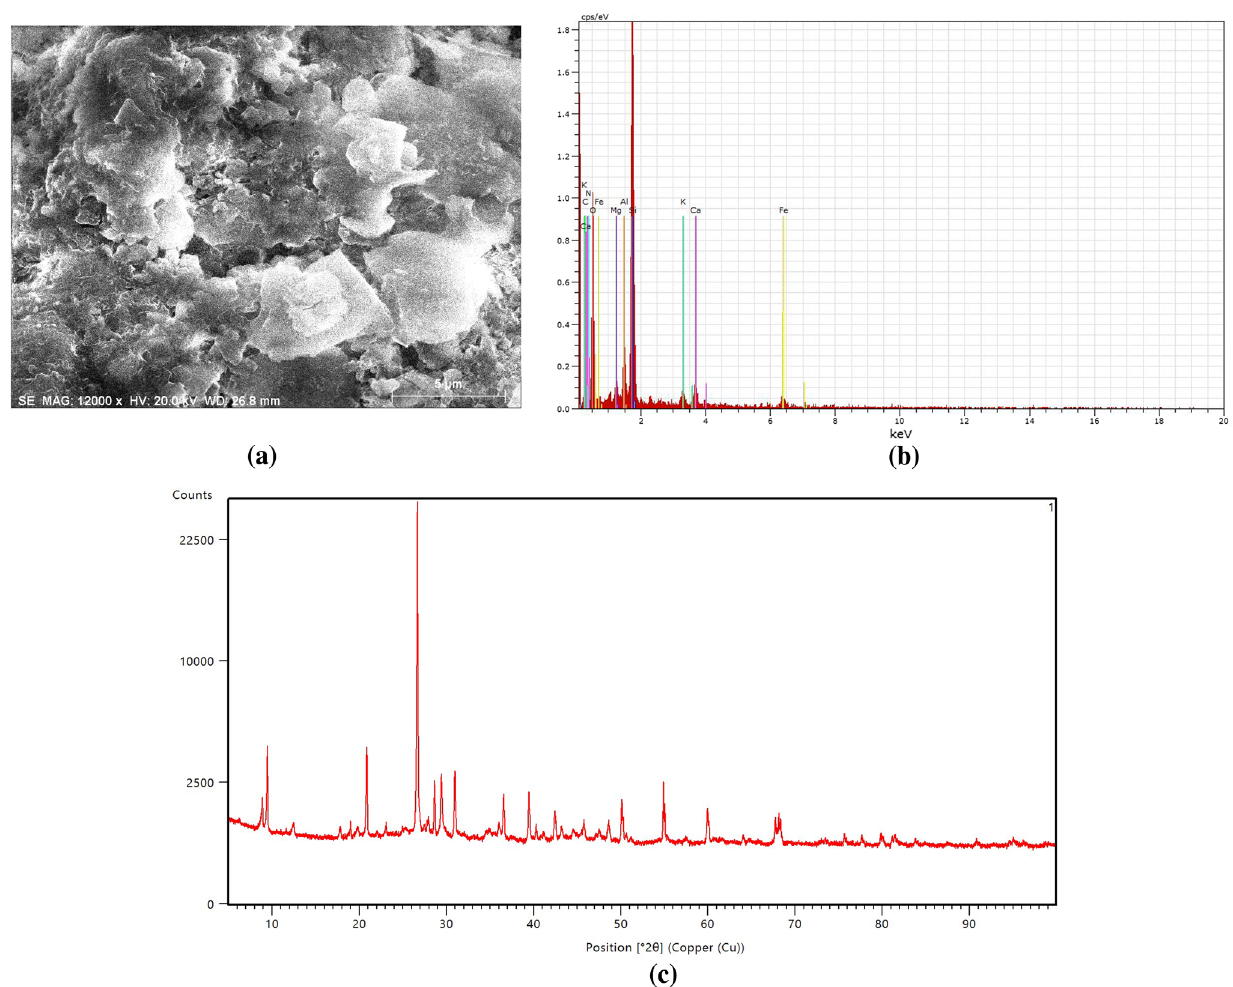
Fig. 5 SEM, EDS and XRD analyses of 20th day compost (Mandi